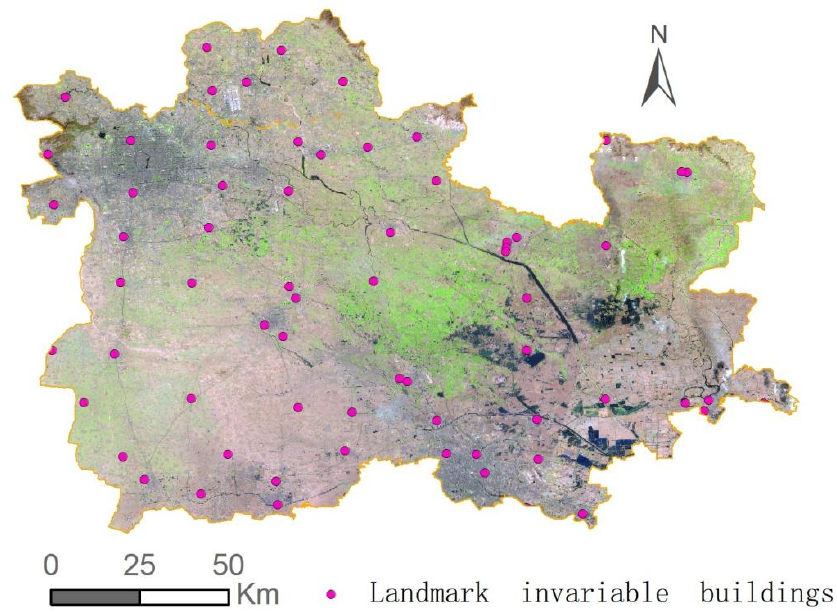
Figure 3. 100 landmark invariable buildings were selected as control points.